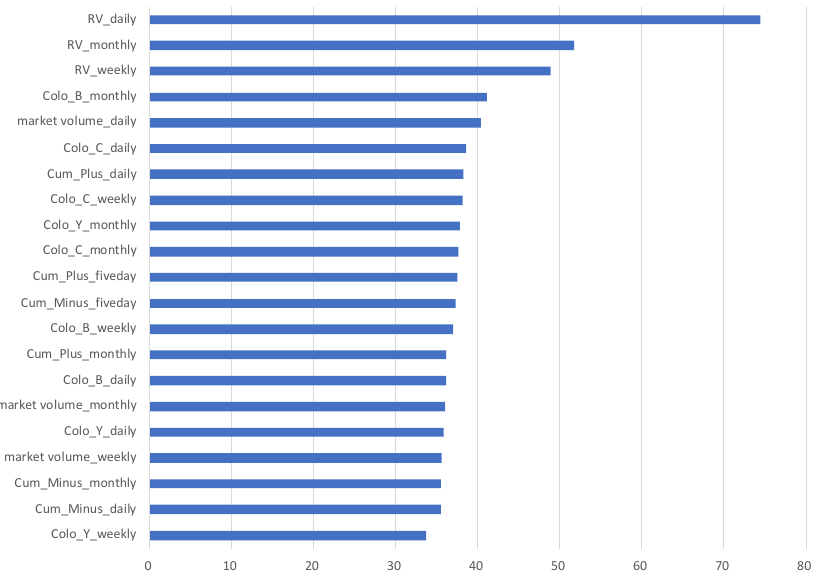
Figure 3. Important variables in the total observation period.